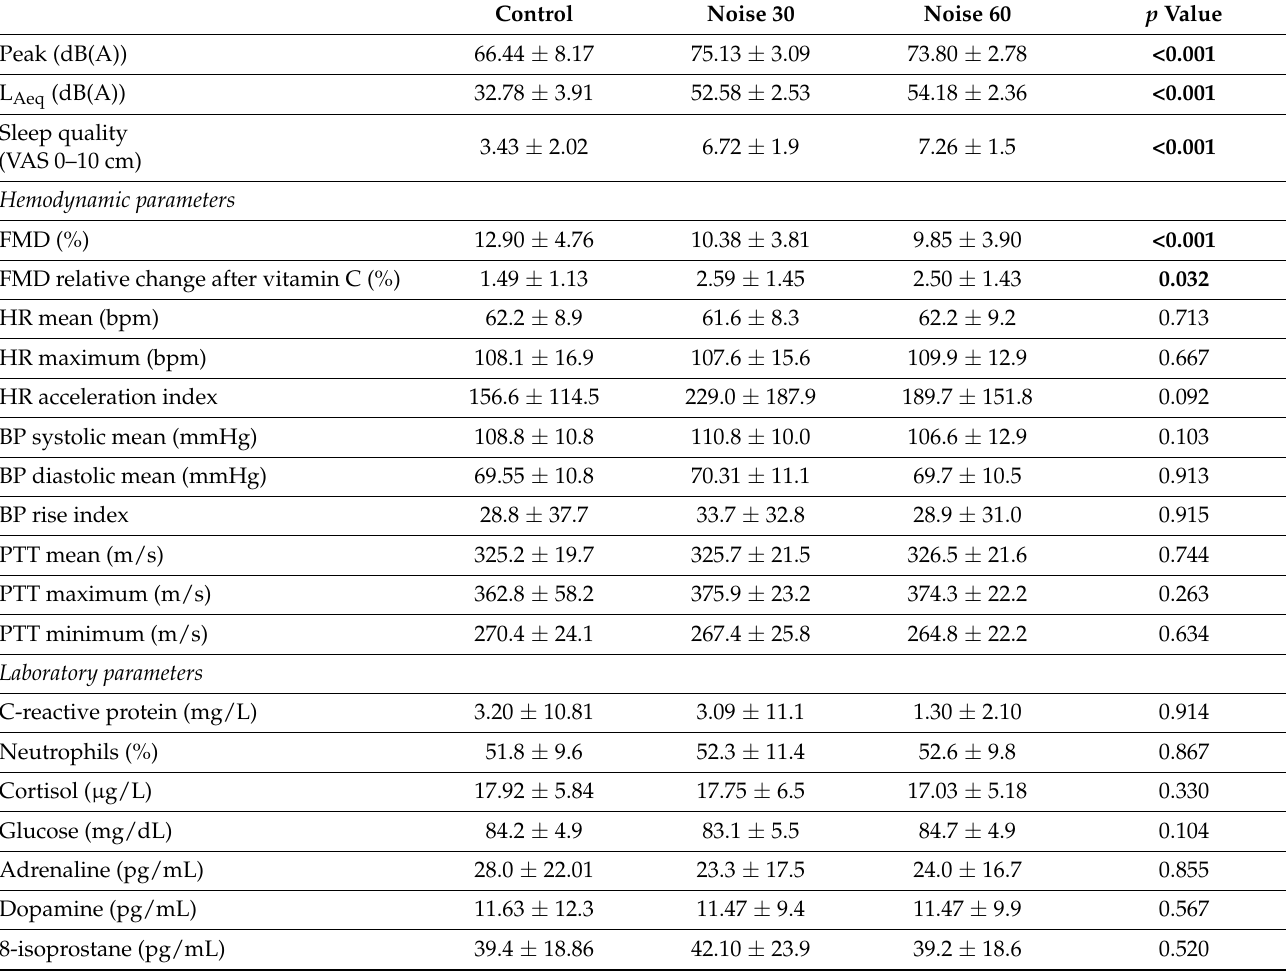
Table 2. Effects of nocturnal train noise on sleep quality, hemodynamic, and laboratory parameters in women ( n =